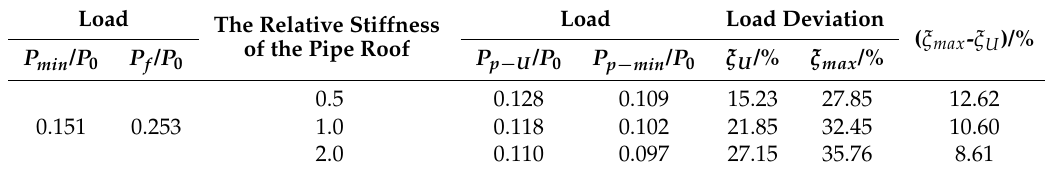
Table 3. Influence of the pipe roof on the key pressure